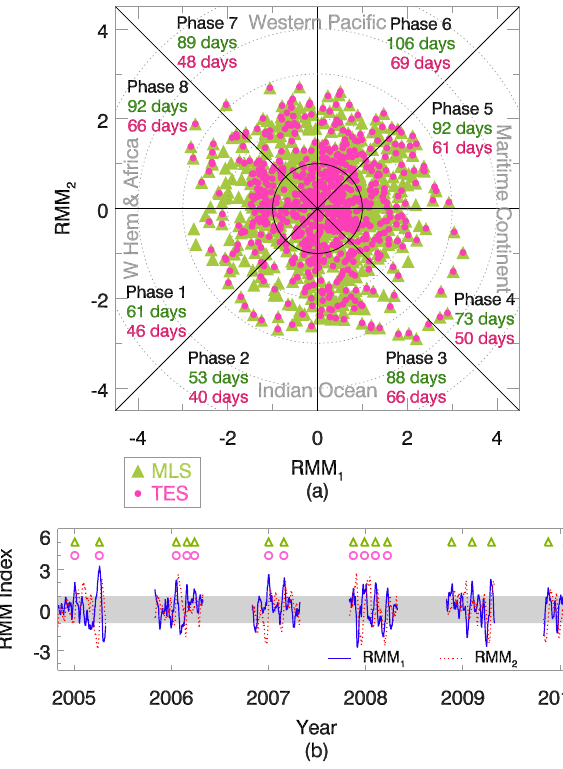
Fig. 1. (a) The number of days constituting each MJO phase during the observational periods of interest. Only days with strong MJO activity RMM 2 +RMM 2 ≥ 1 are considered. The green triangles represent days with MLS O 3 observations during the boreal winters (Novembers–Aprils) of November 2004–February 2010; the red dots represent days with TES O 3 observations during the boreal winters of September 2004–August 2008. (b) The time series of RMM indices. The strong MJO events during the observational periods are denoted by the triangles and circles for MLS and TES, respectively. The indices lying in the grey region are considered to be weak MJO events and are ignored in the